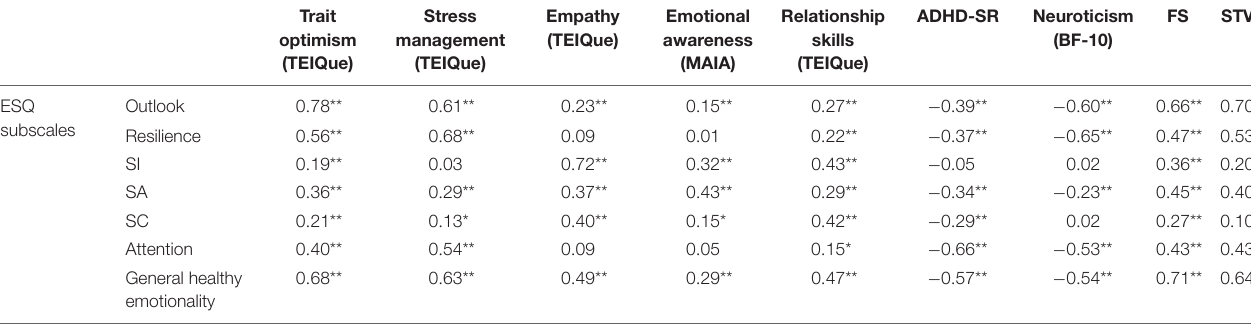
TABLE 4 | Correlations between the ESQ and the corresponding (sub) scales used for validation (Study II). Trait